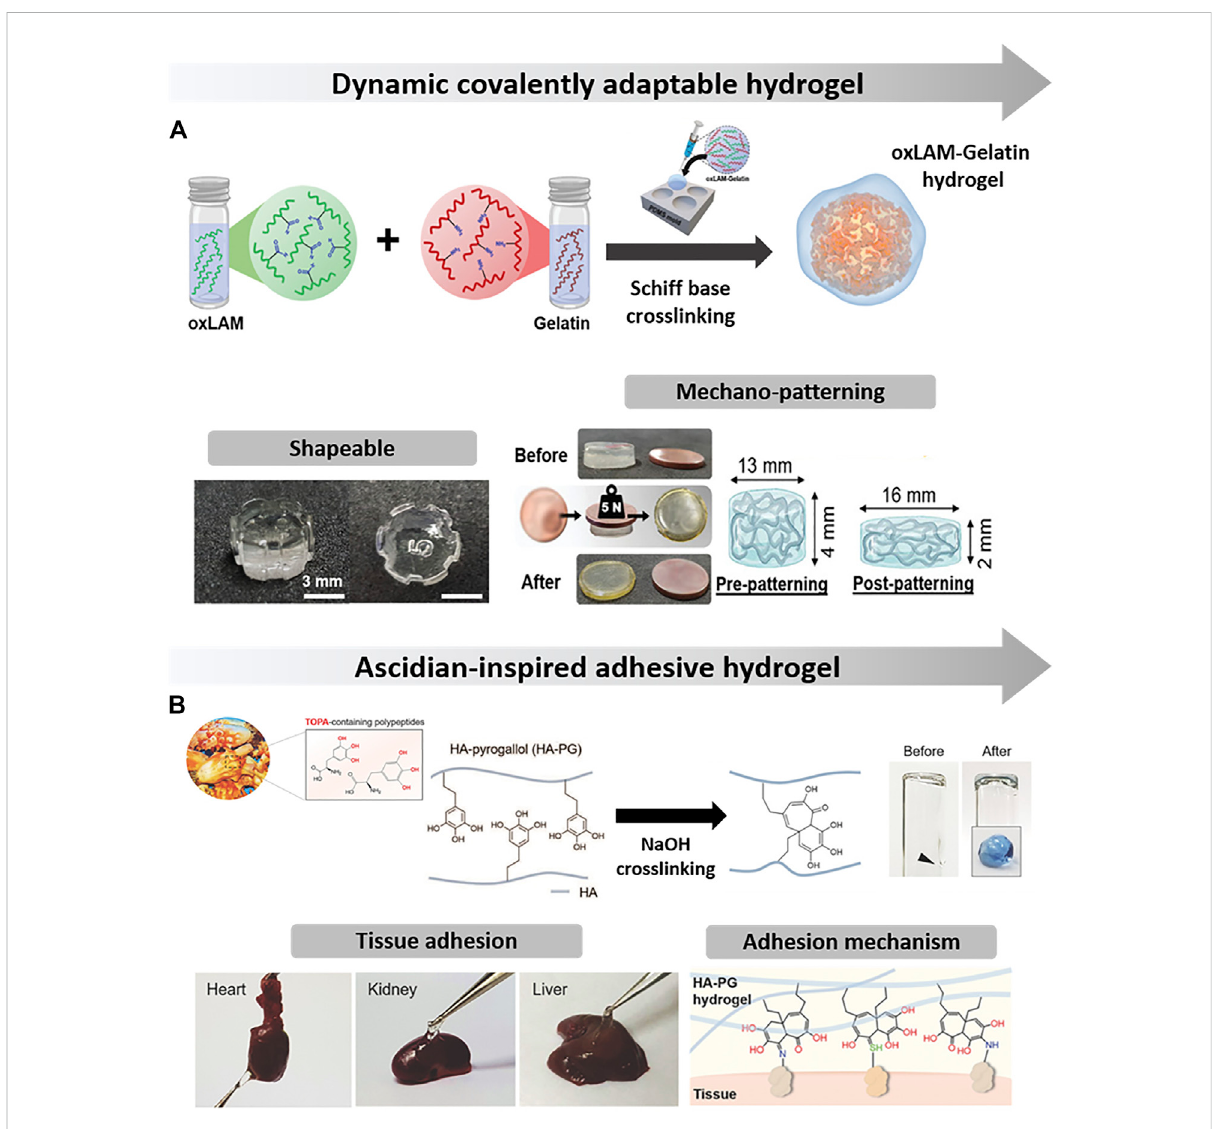
FIGURE 5 (A) Dynamiccovalentlyadaptablehydrogels imprinted with ananisotropicnanotopographical con fi guration where cellshave aligned alongthe intercalating nanoridge topography. Adapted from (Lavrador et al., 2020) with permission from John Wiley & Sons, Copyright 2020 WILEY-VCH Verlag GmbH & Co. KGaA, Weinheim; (B) Ascidian-inspired gallol-modi fi ed hyaluronic acid hydrogel adhered to various organs through